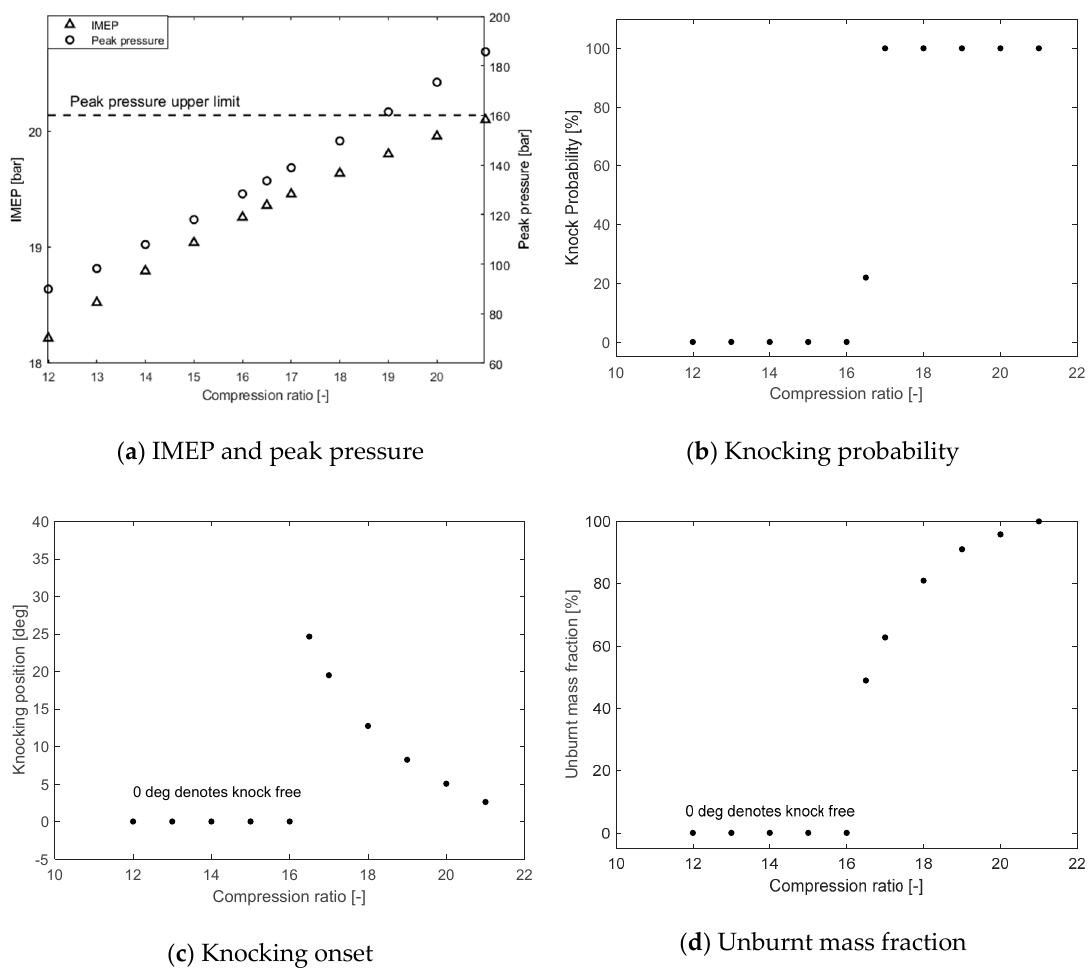
Figure 8. Compression ratio effect on engine performance and knocking parameters (Engine B).